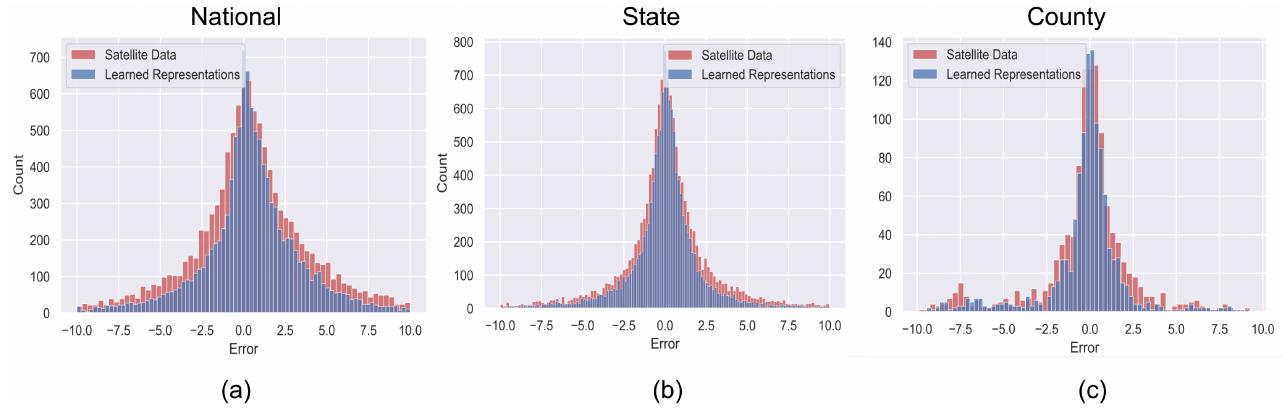
Figure 9. Histogram of error bars of the satellite data and learned representations Random Forest models: ( a ) national model, ( b ) state model, and ( c ) county model errors have been limited from −10 to 10 for better visibility.